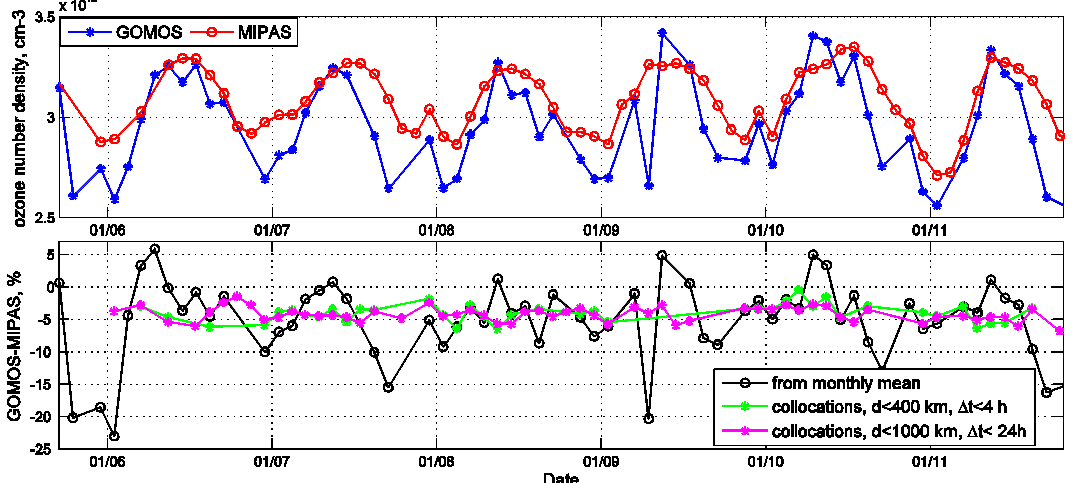
Fig. 2. Top: monthly zonal mean ozone number density at 15 hPa (~30 km), latitudes 40 ° N-60 ° N. Bottom: relative difference of GOMOS and MIPAS ozone at 15 hPa, for the same latitude zone 40 ° N-60 ° N estimated using monthly zonal mean data (black line) and using collocated GOMOS-MIPAS data (green and magenta lines).